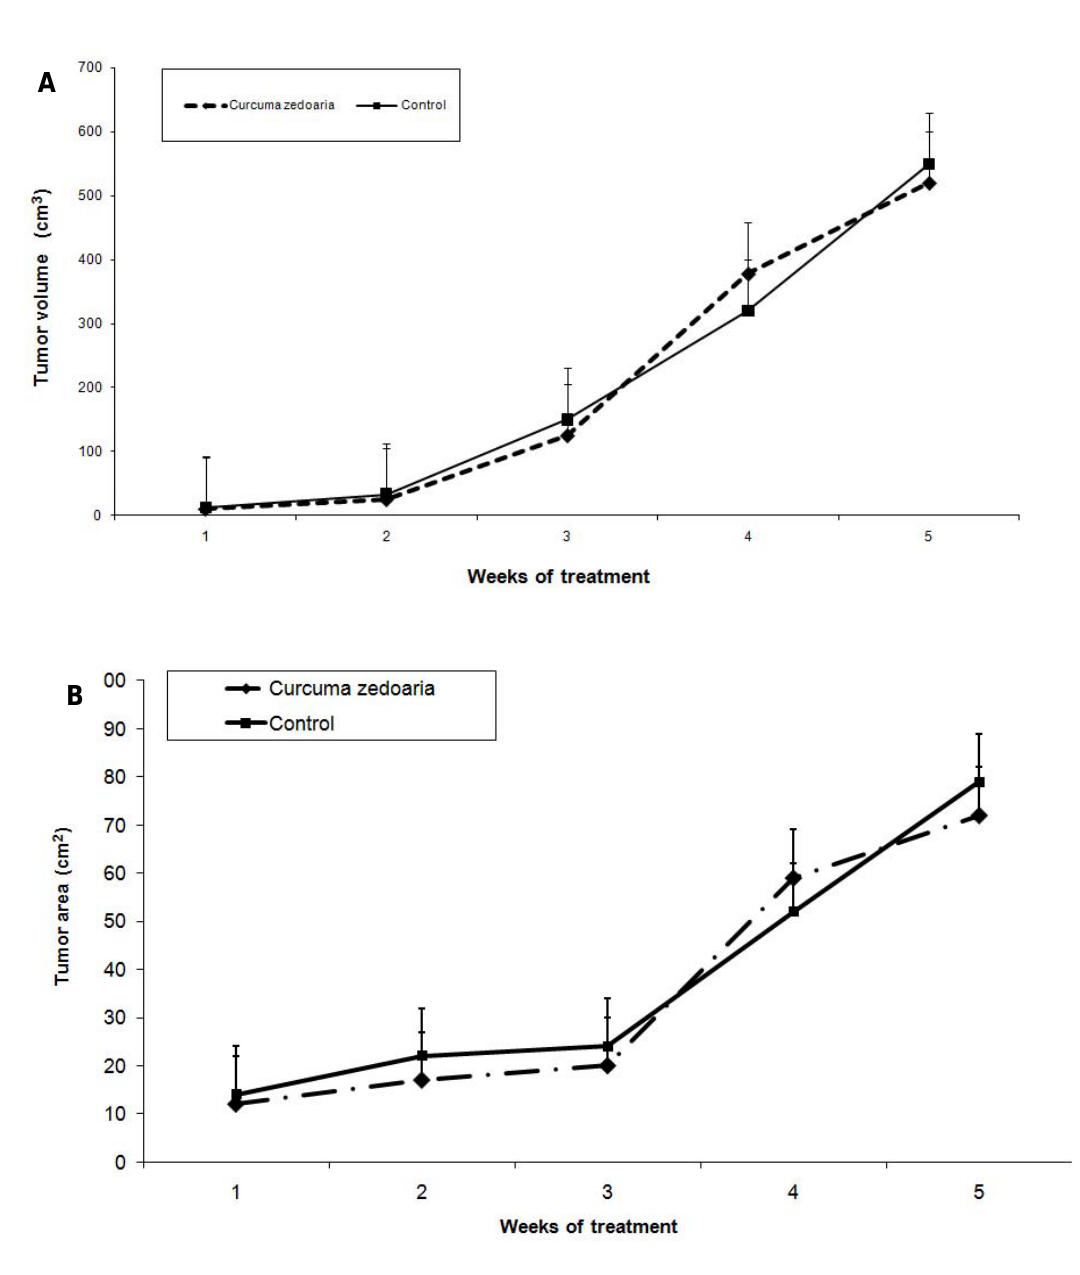
Figure 6. ( A ) Analysis of dorsal B16F10 tumor growth in C57BL/6J mice treated with 0.2% Curcuma zedoaria. ( B ) Analysis of dorsal B16F10 tumor area in C57BL/6J mice treated with 0.2% Curcuma zedoaria. Data are expressed as mean ±